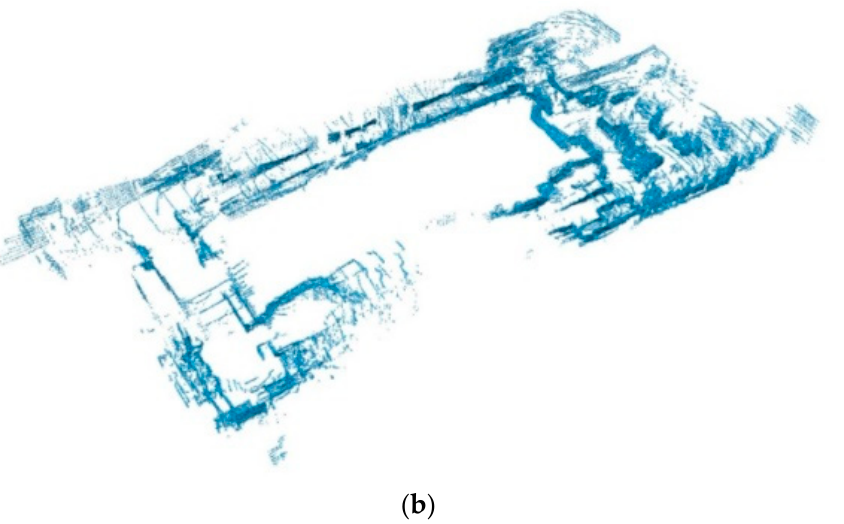
Figure 5. Maps obtained before accident: ( a ) created with the use of 2D SLAM technique; ( b ) created with the use of proposed hybrid 3D SLAM approach.